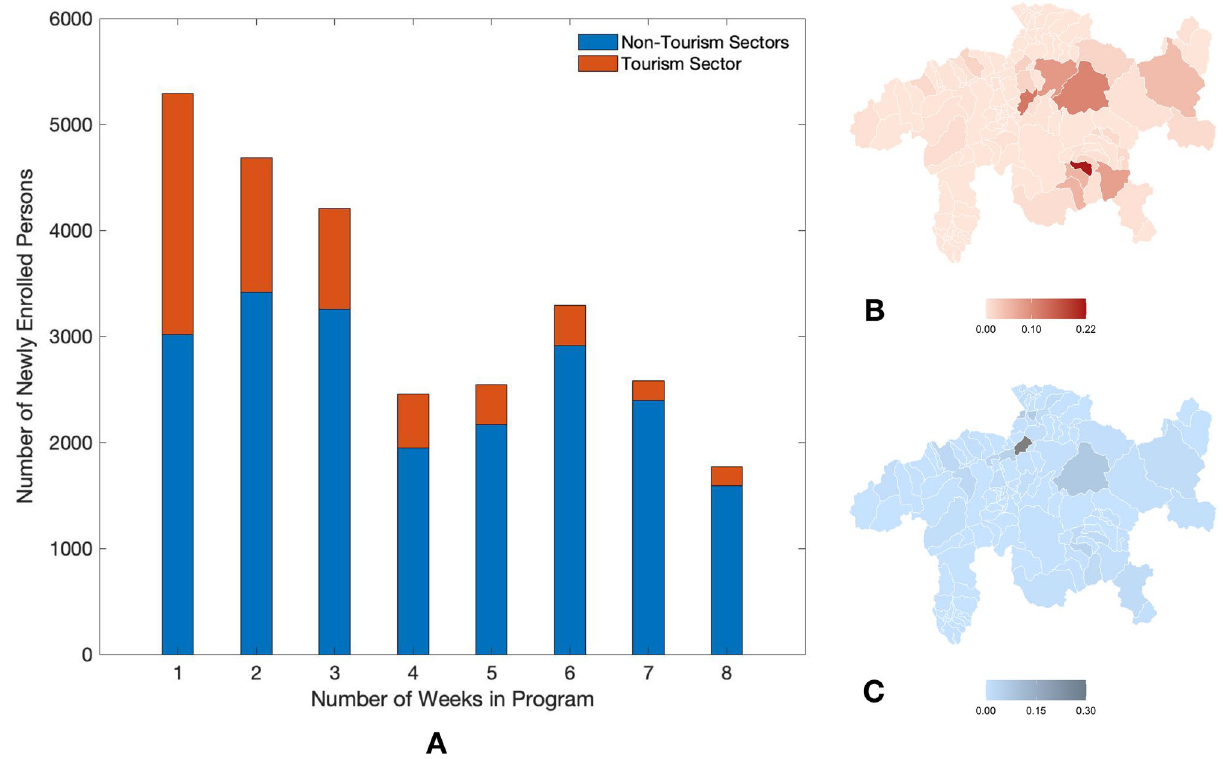
Figure 2. Enrollment and geographic distribution. ( A ) Number of newly enrolled employees versus the number of weeks since initiation of the program. ( B , C ) The geographic distribution of work-places of program participants in tourism sector and non-tourism sectors, respectively (see Fig. 3 in Supplementary materials for more details). The maps were generated by the R package RSwissMaps http:// cran. nexr. com/ web/ packa ges/ RSwis sMaps/ index.